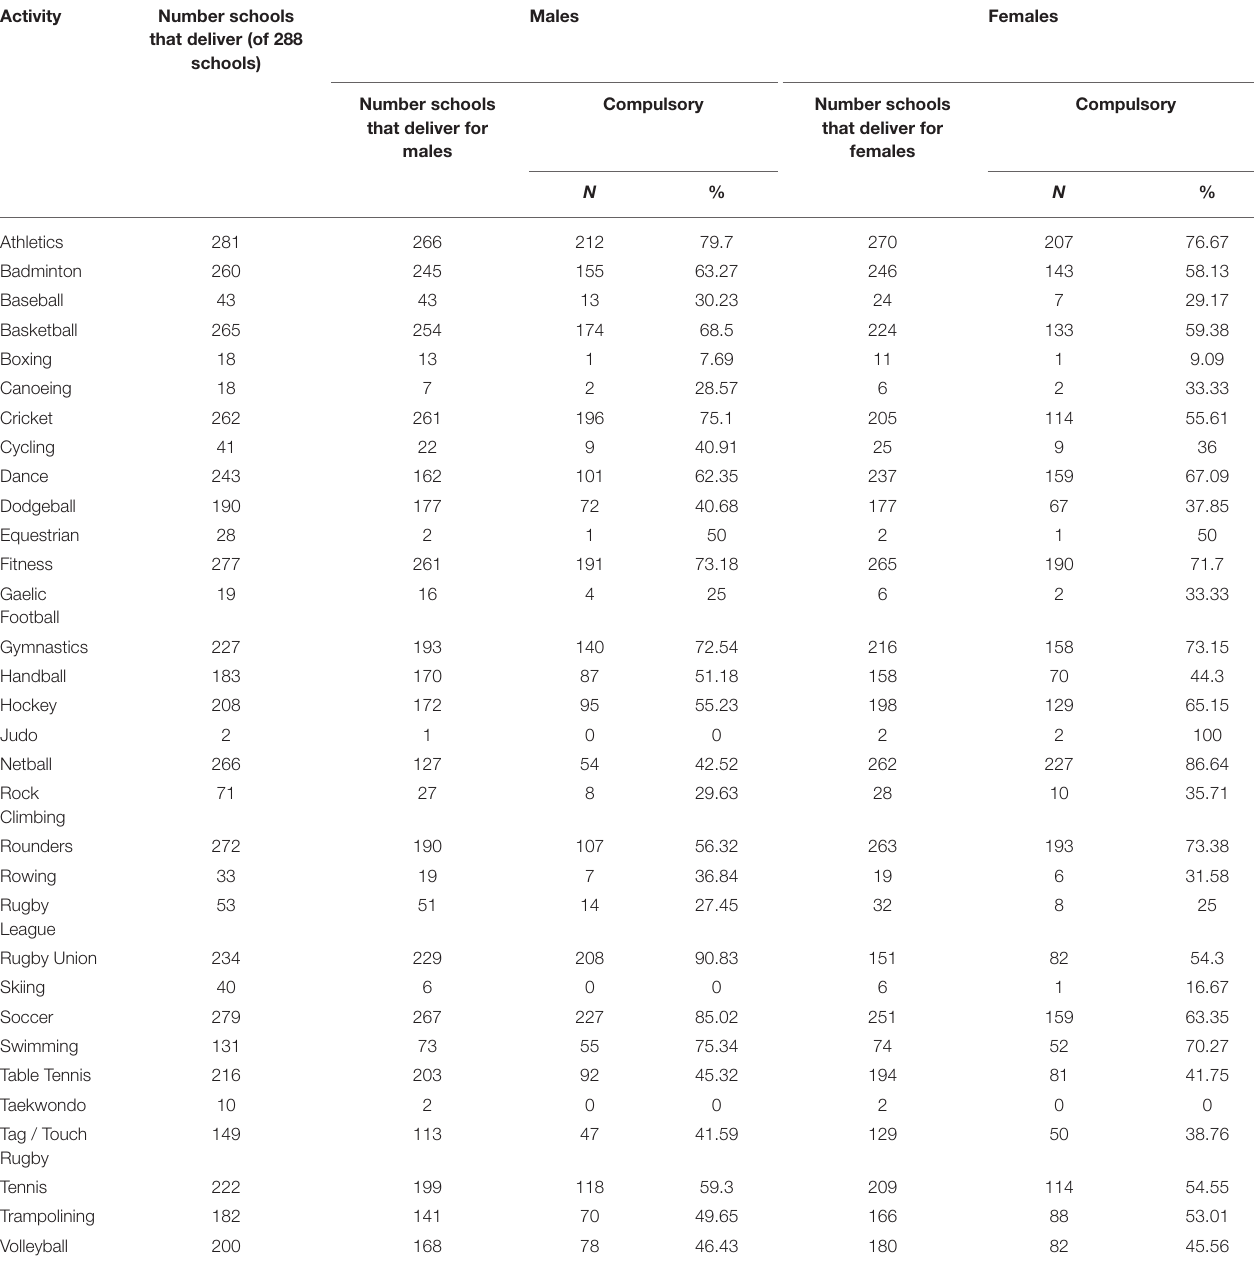
TABLE 1 | The number of schools that make activities compulsory by gender. Activity Number schools Males Females that deliver (of 288 schools) Compulsory Number schools Number schools that deliver for that deliver for females males